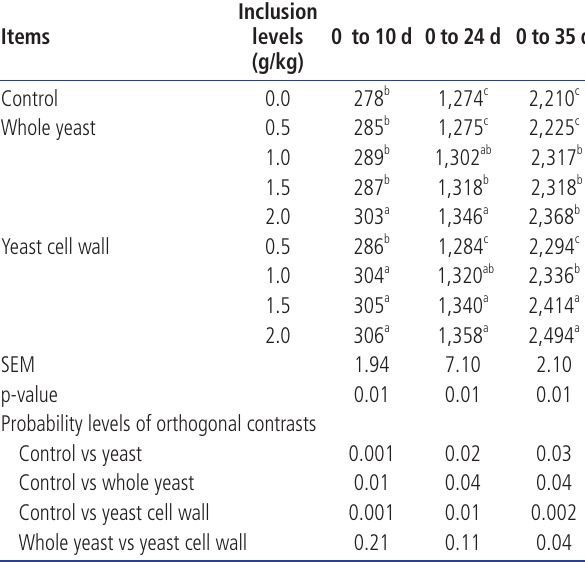
Table 3. Effects of dietary treatments on body weight gain (g/bird) of chicks at different ages Items